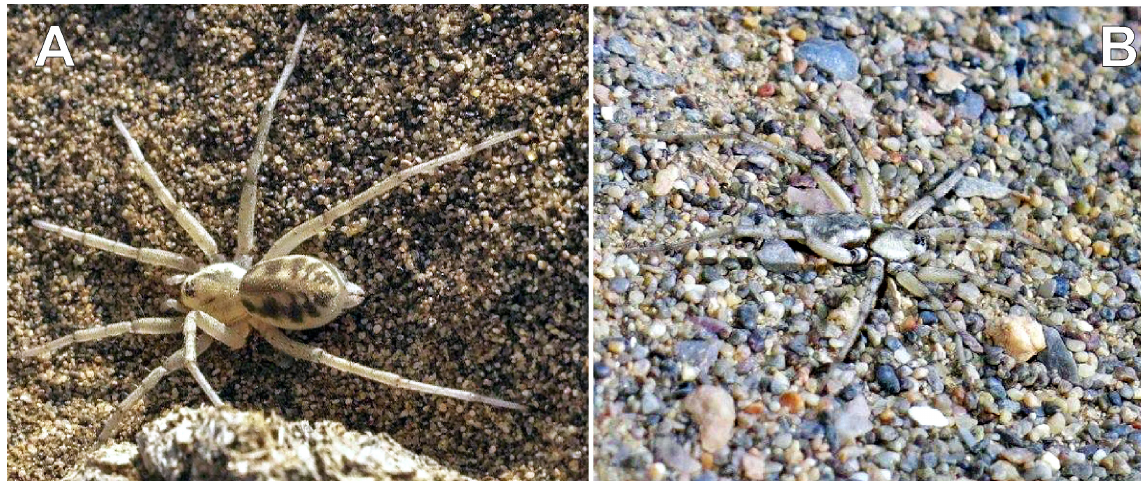
Fig. 6. Callipelis deserticola Zamani & Marusik, 2017, ♀, live habitus. A . Specimen from Rig-e Jen, Semnan Province (courtesy of Ali Mohajeran). B . Specimen from Ardakan, Yazd Province (by Alireza